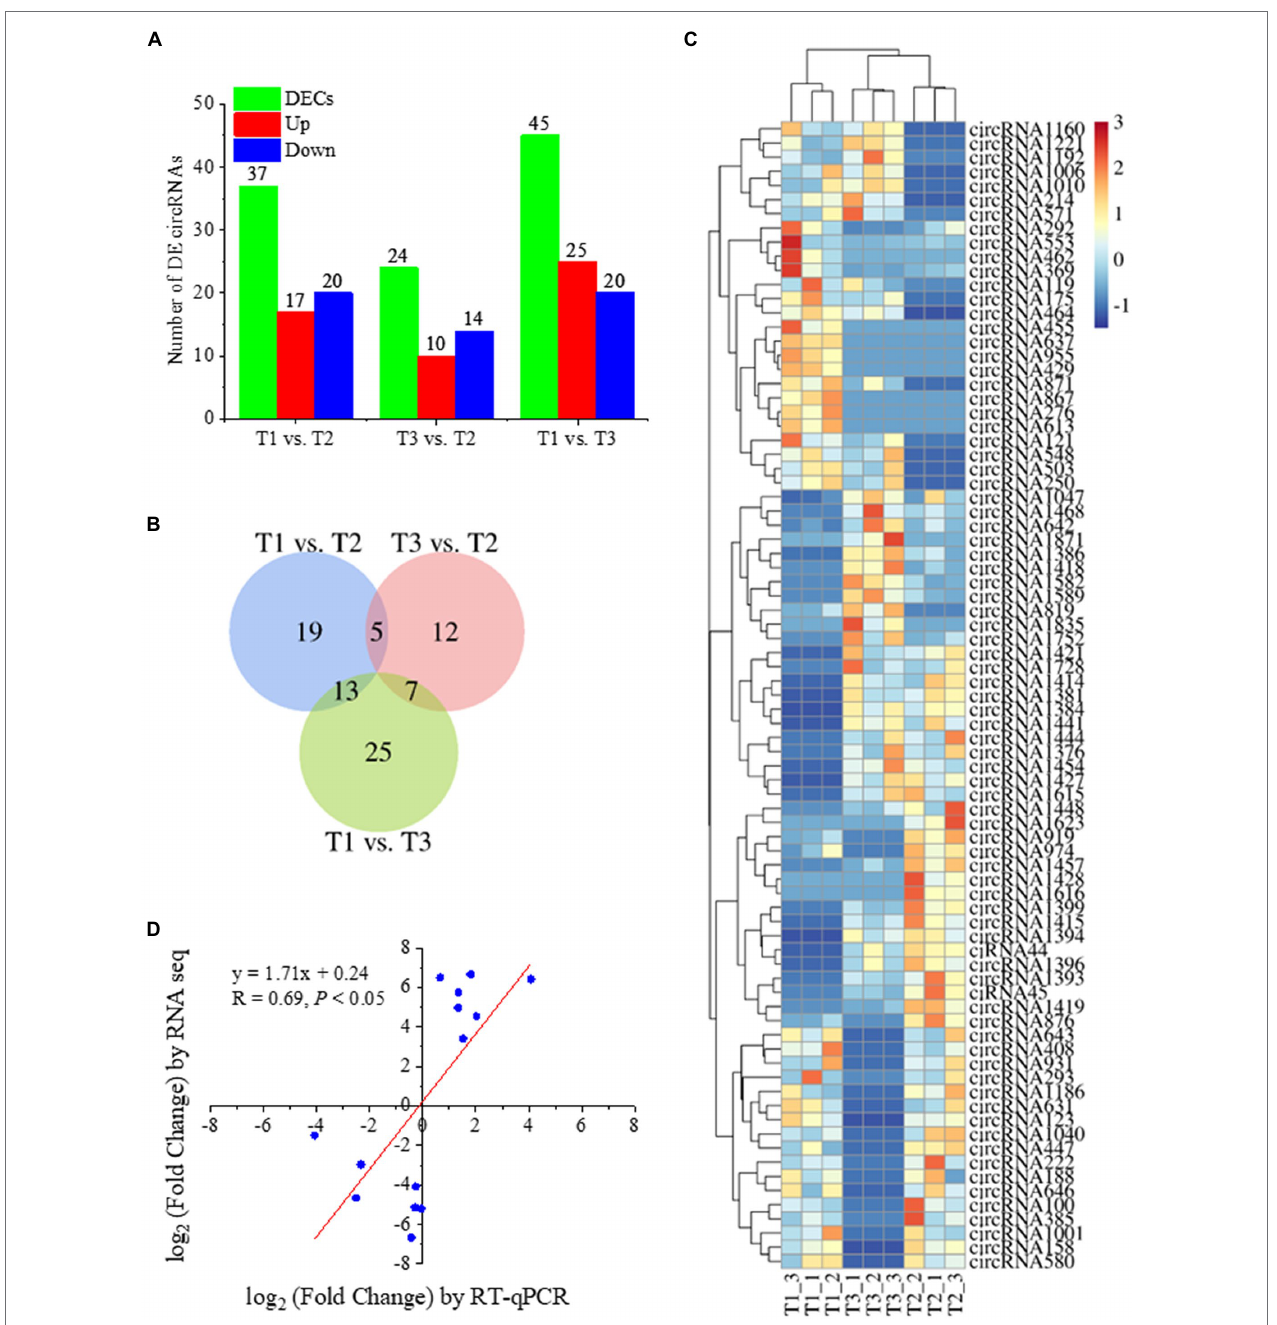
FIGURE 3 | Statistical analysis of identified DECs in Tl, T2, and T3 of P. × canescens . (A) The number of upregulated and downregulated DECs in each comparison; (B) Venn diagram analysis of DECs; (C) heatmap of DECs; (D) Quantitative RT-qPCR validation of